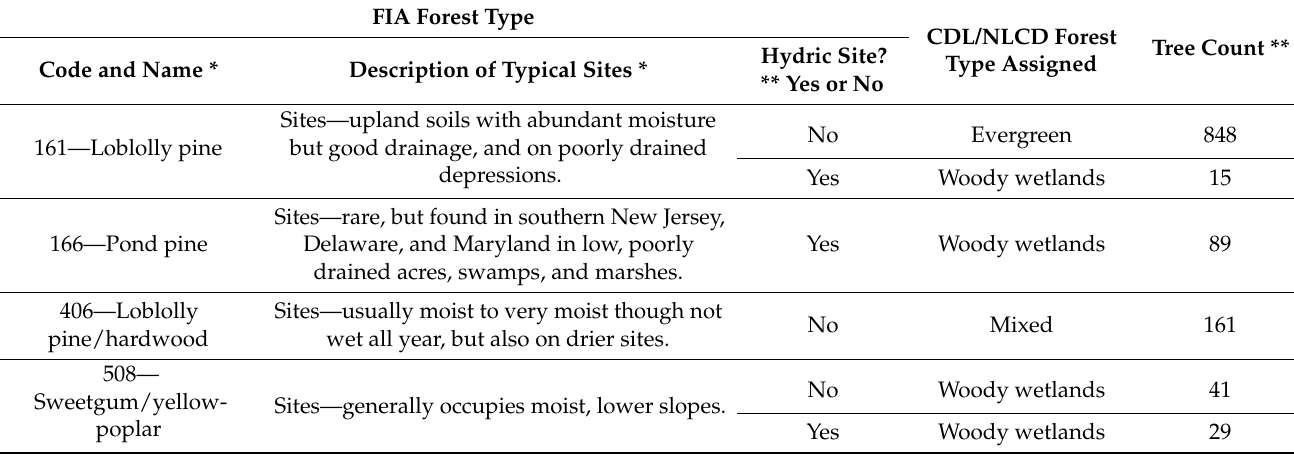
Table 3. FIA vs. CDL/NLCD forest types: Duplin County, individual tree data from the 2009–2013 FIA.